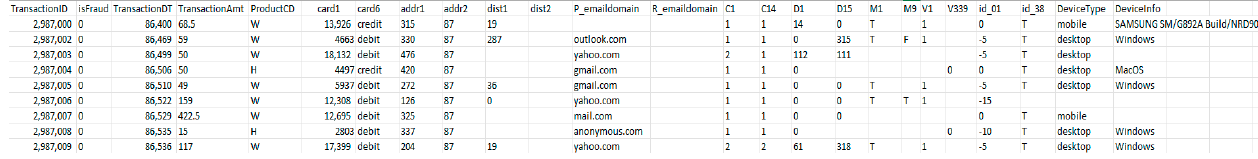
Figure 1. Sample of the used dataset before prepossessing phase.